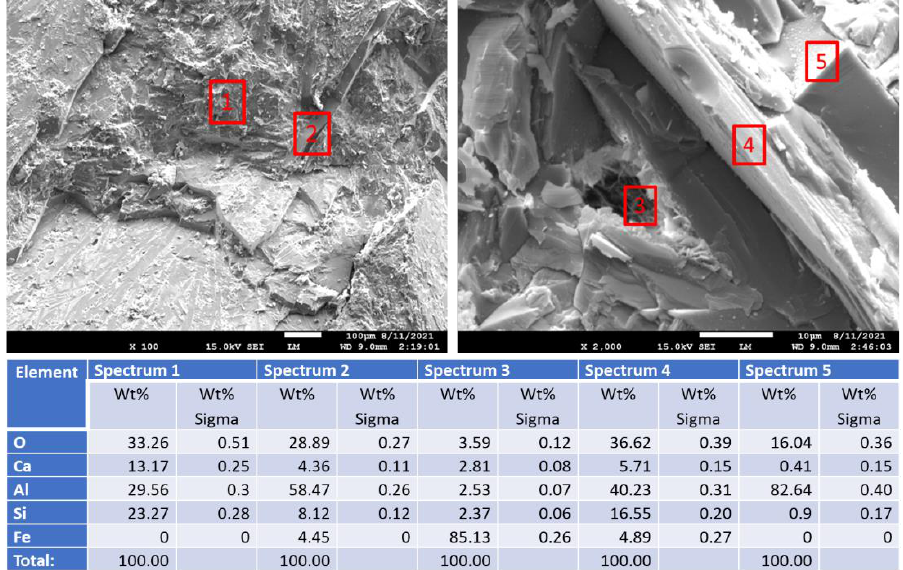
Figure 30. Photomicrographs of anorthite samples with the elemental composition of typical sites shown by red boxes after alkaline carbonation at 250 ◦ C for 40